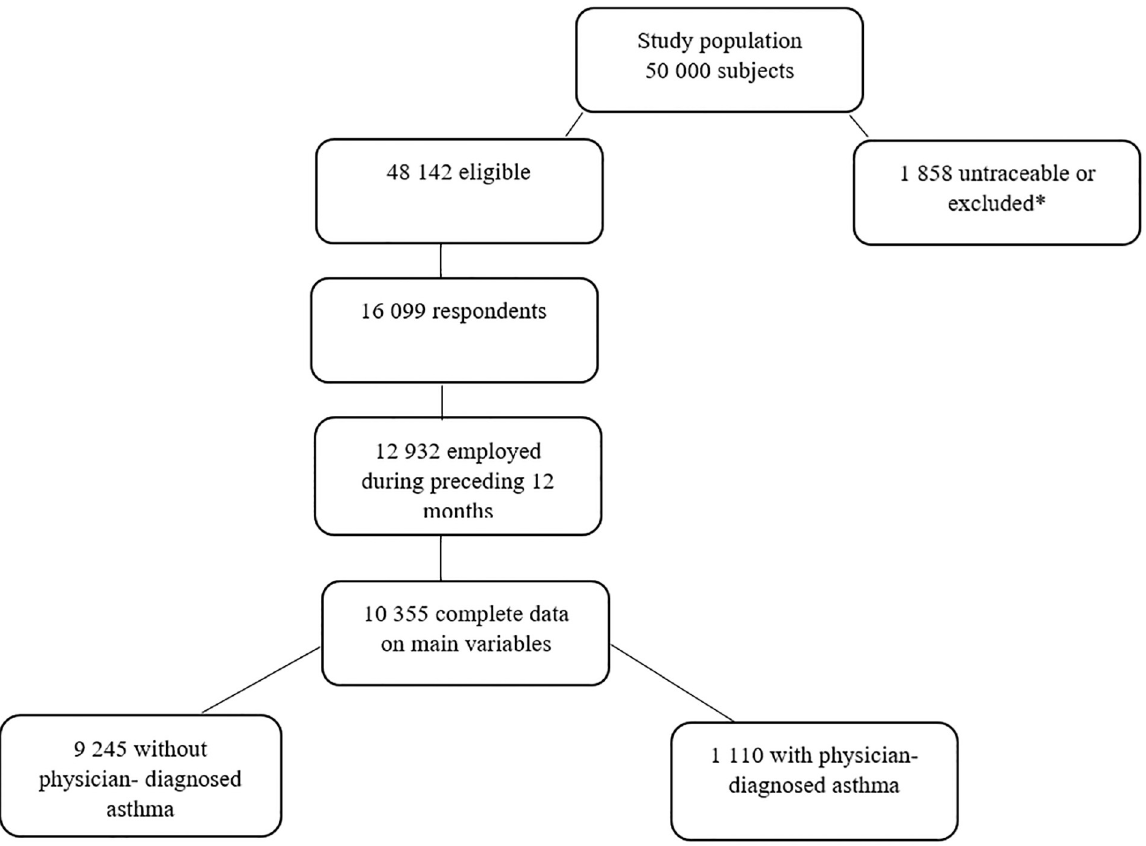
Fig 1. Unknown address or language